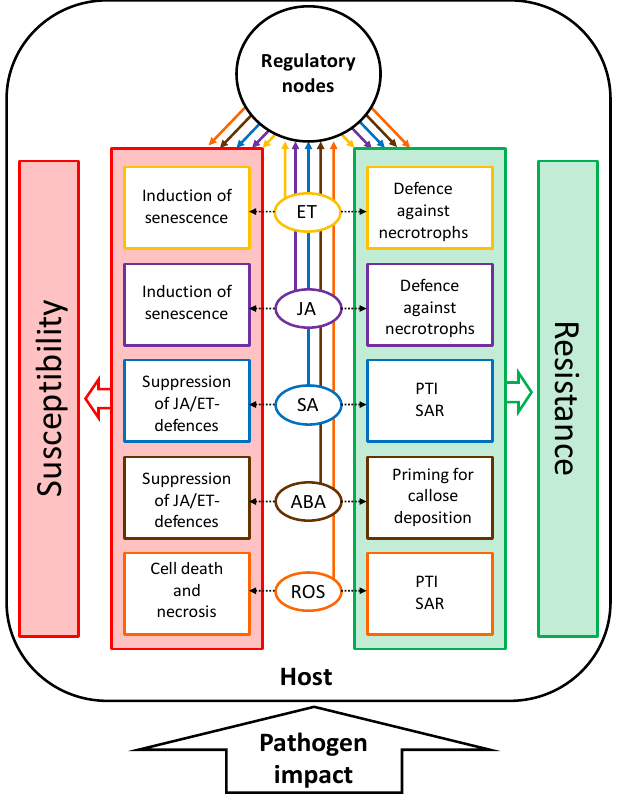
Figure 7. A model for the roles of potentially senescence-inducing signaling molecules during necrotrophic host-pathogen-interactions. Ethylene (ET), jasmonic acid (JA), salicylic acid (SA), abscisic acid (ABA) and reactive oxygen species (ROS) are usually induced during necrotrophic interactions. If the senescence-promoting effects prevail, host susceptibility will be increased. If the host succeeds to restrict signaling events to defence-related branches, resistance can be achieved. Regulatory nodes, such as transcription factors, may act as molecular switches between signaling branches. Colored arrows symbolize signaling pathways triggered by different signaling molecules. Dashed arrows symbolize potential responses. PTI = PAMP-triggered immunity, SAR = systemic acquired resistance, PAMP = pathogen-associated molecular